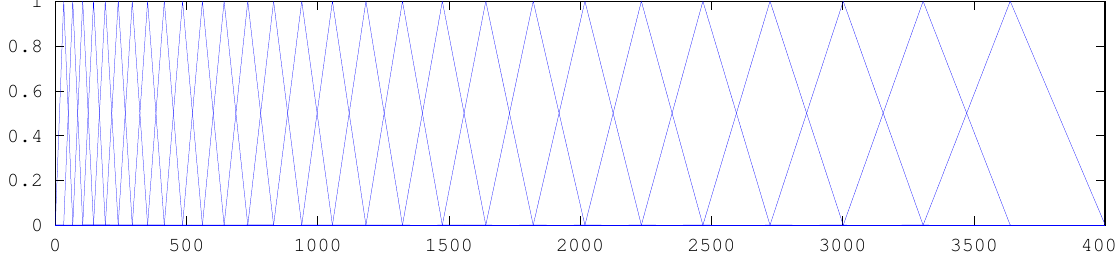
Figure 3. Mel (melody)-spaced filter bank.